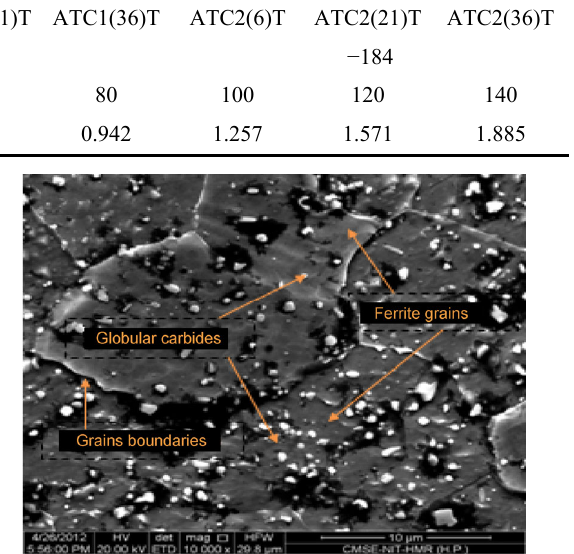
Fig. 2 FESEM micrograph photo of AISI H13 steel in the received condition.